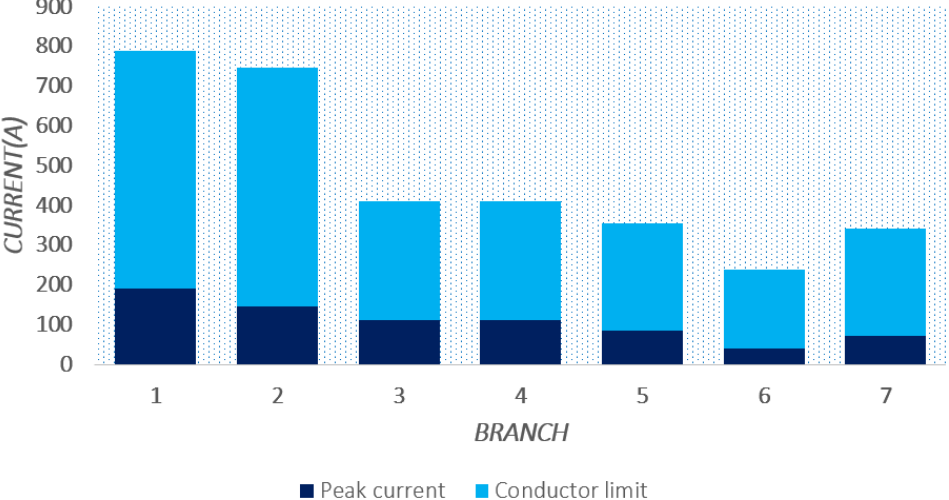
Figure 4. Behavior of the current in the branches for the IEEE system of 8 buses (balanced).